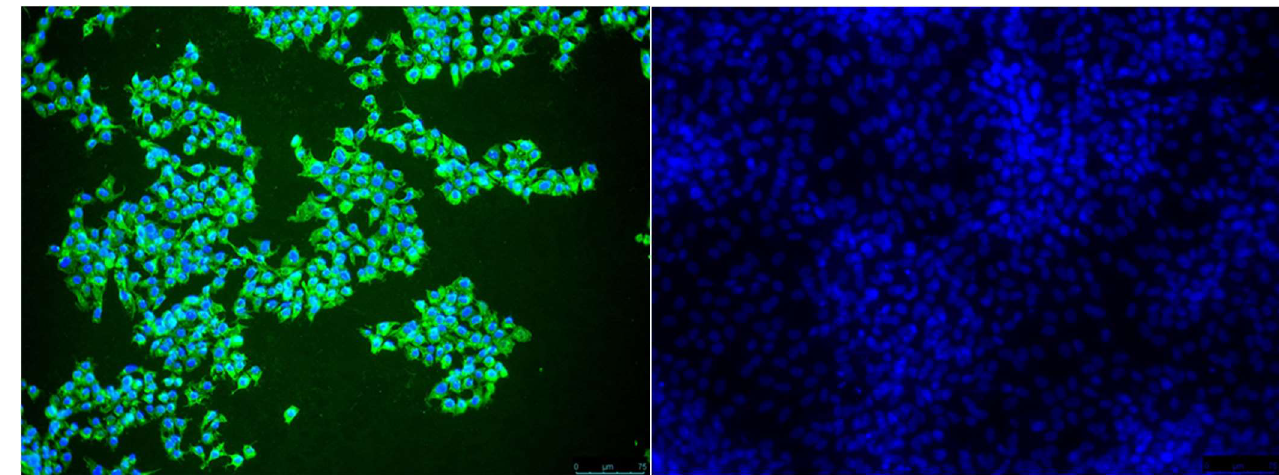
Figure 3. Japanese encephalitis virus isolation from mosquito saliva. JEV was isolated from the saliva of a Culex pipiens mosquito collected at 14 dpi from the constant 25 ◦ C temperature condition (left panel). Saliva of a non-blood fed mosquito was included as a negative control (right panel). The second passage on Vero cells was stained for JEV with a primary anti-JEV NS1 antibody and secondary Alexa Fluor ® 488 anti-mouse IgG2b Antibody (green). Cell nuclei were stained with Hoechst (blue).